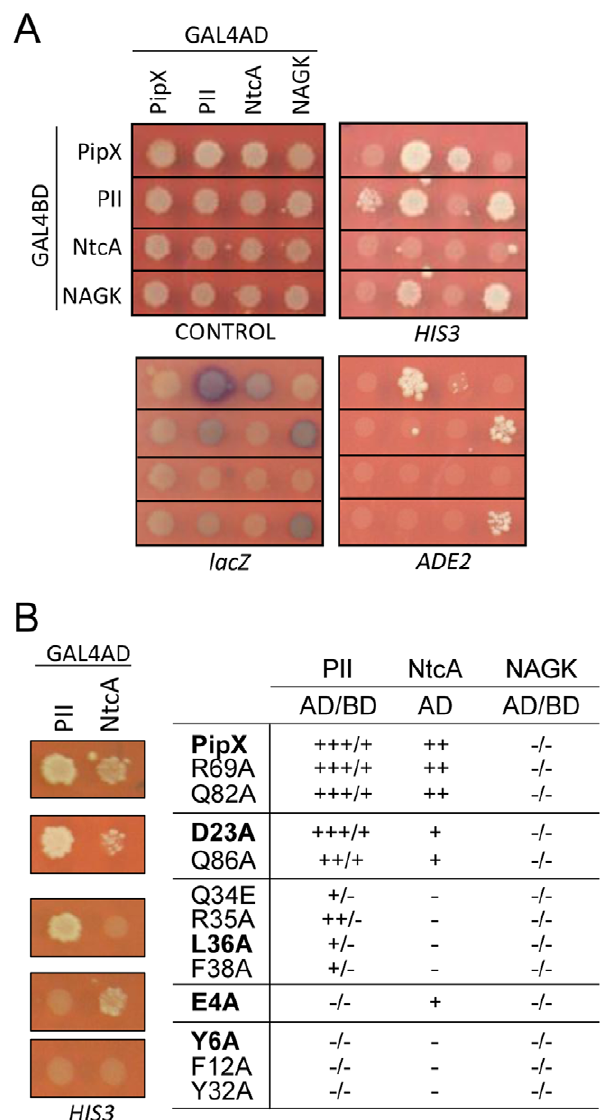
Figure 2. Effect of PipX substitutions in yeast two hybrid interaction signals. (A) An illustrative yeast two hybrid Interaction assay involving wild type PipX, P II , NtcA and NAGK proteins fused to either GAL4AD and GAL4BD. Photographs show growths on diploid media (CONTROL), on histidine ( HIS3 ) and adenine ( ADE2 ) minus media, and x-gal test ( lacZ ) on a diploid plate. (B) Yeast two hybrid interaction pattern of PipX point mutants. Growth of diploids carrying GAL4AD:P II or GAL4AD:NtcA and the wild type (PipX) or the BD:PipX substitutions indicated in bold type (representative for each group of proteins), on minus histidine medium. The table summarizes the level of interaction signals between fusions of GAL4AD and GAL4BD to PipX derivatives and their complementary domains fused to P II , NtcA and NAGK (negative control), as indicated. Signs (from +++ to -) indicate levels of yeast two-hybrid expression from HIS3 , ADE2 and lacZ reporters according to previously described conventions [8]. doi:10.1371/journal.pone.0035845.g002 P glnB ::luxAB than with P glnN ::luxAB . Mutation Y6A had the highest impact on luciferase values from each of the two reporters and this effect was almost the same as that observed with the pipX null strain used as control (compare black bars, that is conditions of maximal activation, between Y6A and PipX - ). Mutations R35A